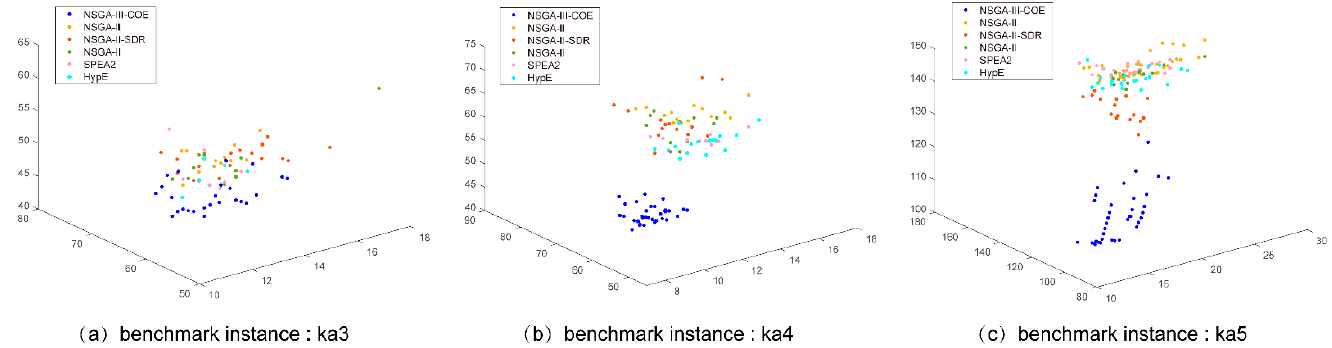
Figure 8. The non-dominated solutions of NSGA-III-COE, NSGA-III, NSGA-II, NSGA-II/SDR, SPEA2, and HypE on instances ka3, ka4, and ka5.